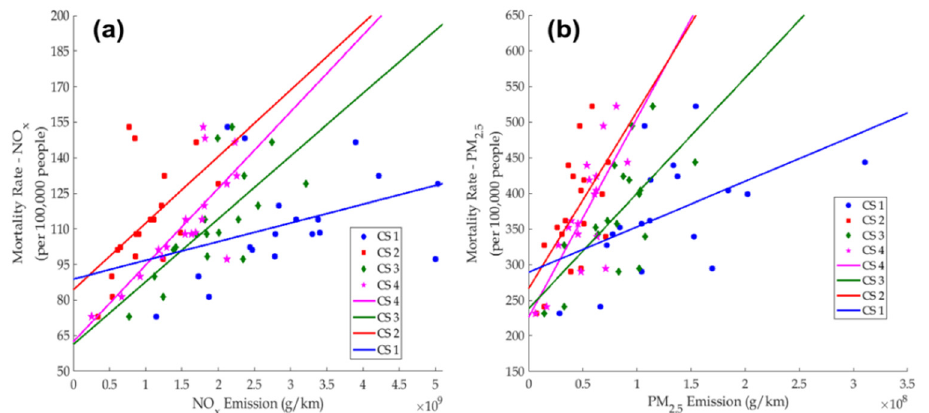
Figure 7. Potential Connection between Mortality Rate of ( a ) NO x versus respective Emissions (10 9 g/km), and ( b ) PM 2.5 versus respective Emissions (10 8 g/km) in all four case studies in Hong Kong districts, with assumptions and uncertainties of Section 2.3 taken into account, together with the corresponding best-fit line obtained by least square regression techniques. Mortality figures are per 100,000 people and based on all disease types as shown in Table 1, while the symbols of each case study (CS) are as stated.